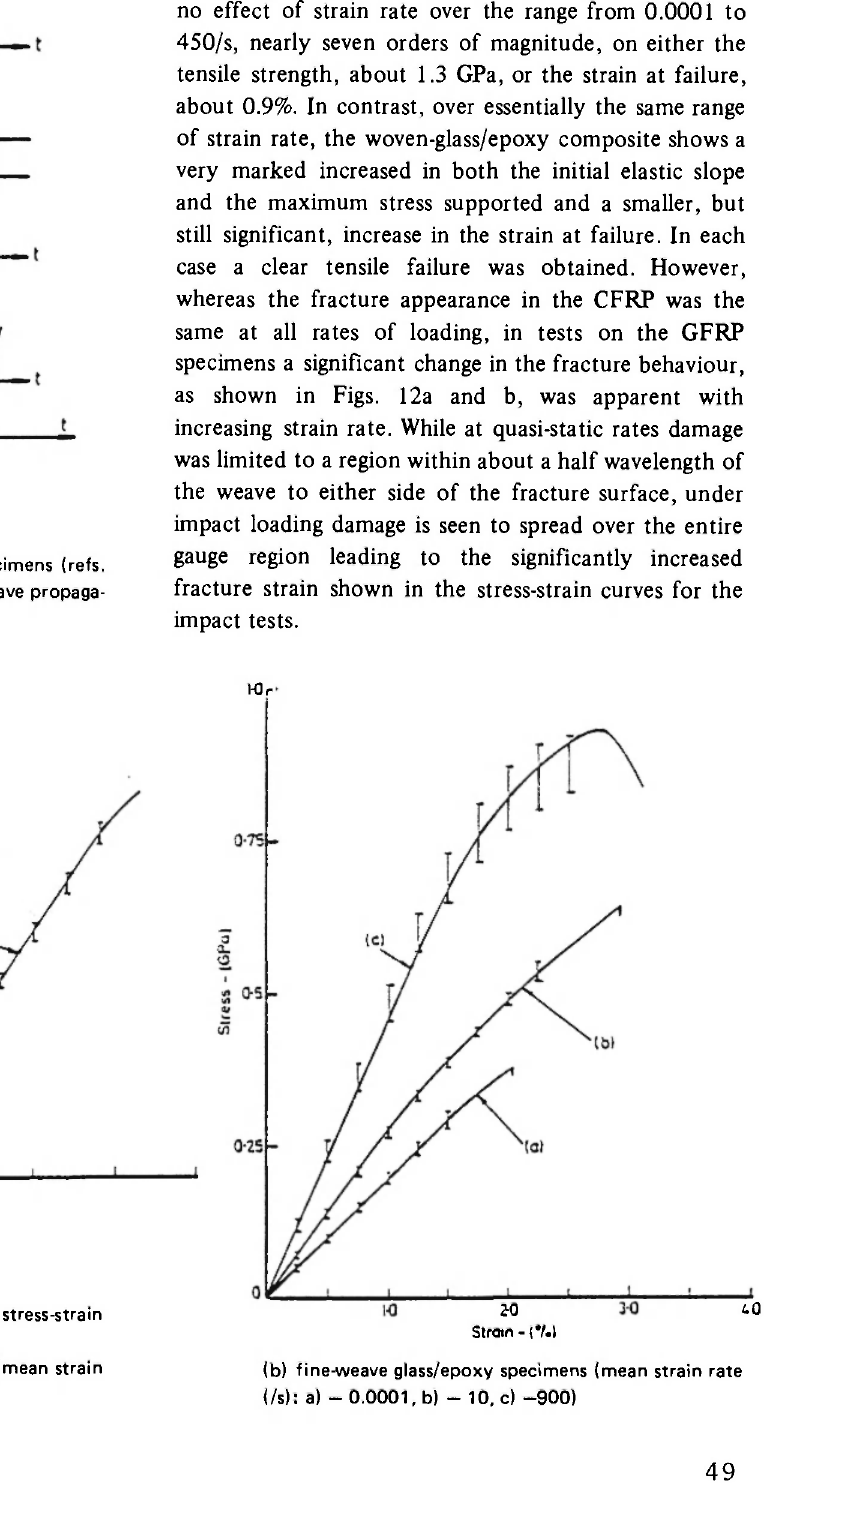
Fig. 10: Tensile Hopkinson-bar for composite specimens (refs. 16,17). (a) test assembly; (b) Lagrange (wave propaga-